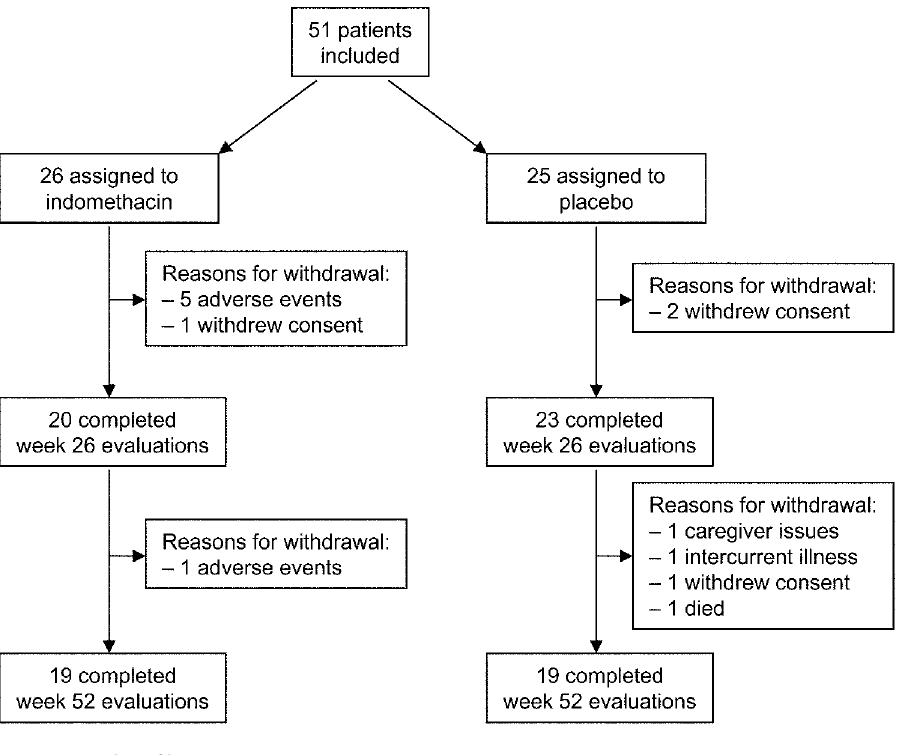
Figure 1. Trial profile.